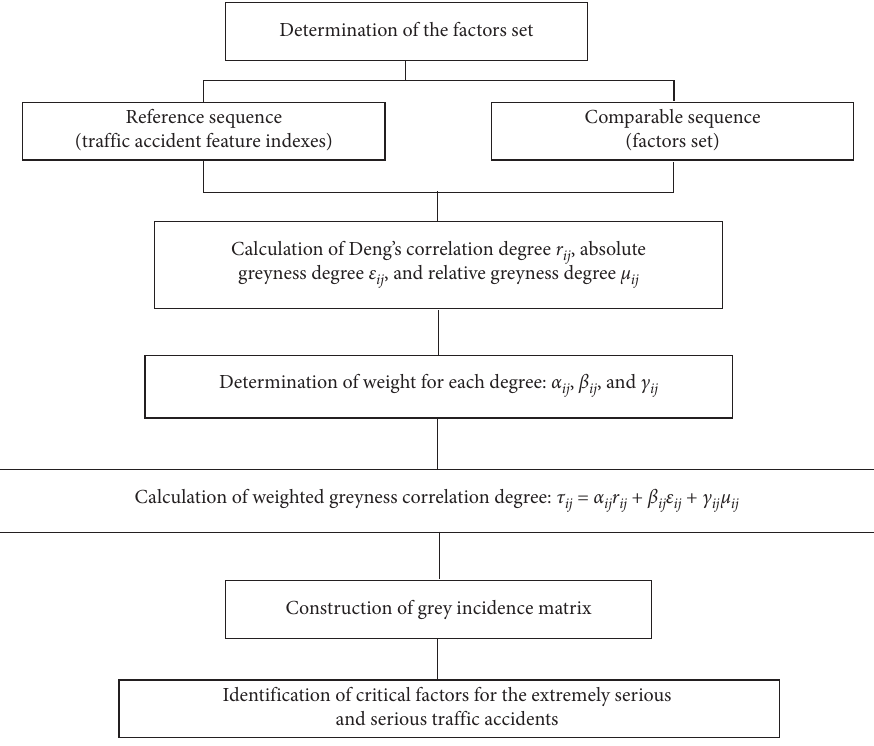
Figure 2: Flowchart of critical factor identification of the severe traffic